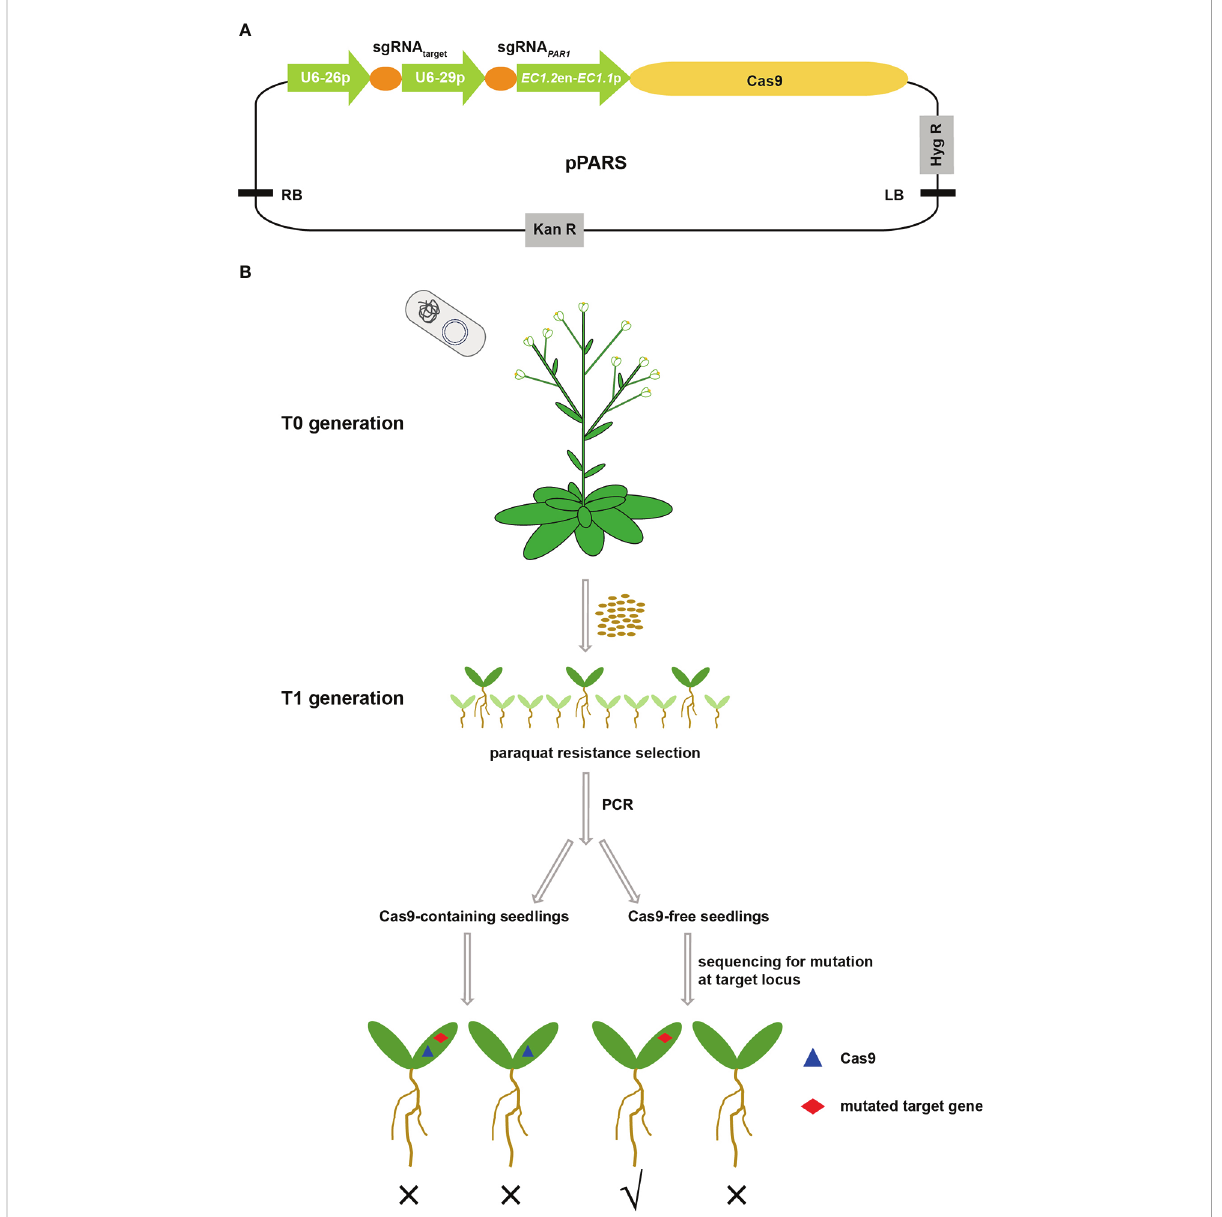
FIGURE 1 Schematic showing the PARS strategy to screen transgene-free gene edited plants. (A) The structure of the pPARS plasmid. The expression of sgRNA PAR1 and sgRNA target is driven by the U6-29 and U6-26 promoters, respectively. The Cas9 expression cassette includes the EC1 promoter ( EC1.2 enhancer plus EC1.1 promoter) and the CDS of Cas9 . Hyg R, hygromycin resistance gene; Kan R, kanamycin resistance gene; RB and LB, T-DNA right and left borders, respectively. (B) Outline of the PARS strategy. pPARS constructed with sgRNA target was transformed into Col-0 plants by fl oral dip. T0 seeds were collected and sown on paraquat-containing plates to select paraquat-resistant plants, which are shown as large green seedlings. The DNA of paraquat-resistant T1 seedlings was extracted, and PCR was performed using Cas9-speci fi c primers to select transgene-free plants. The Cas9-containing seedlings were discarded, and Cas9-free seedlings were further sequenced for mutation at the target locus to obtain transgene-free gene edited plants. The blue triangle on the seedling indicates insertion of Cas9, and the red diamond indicates mutation at the target site. Portions of the images were modi fi ed from the Microsoft PowerPoint clip art